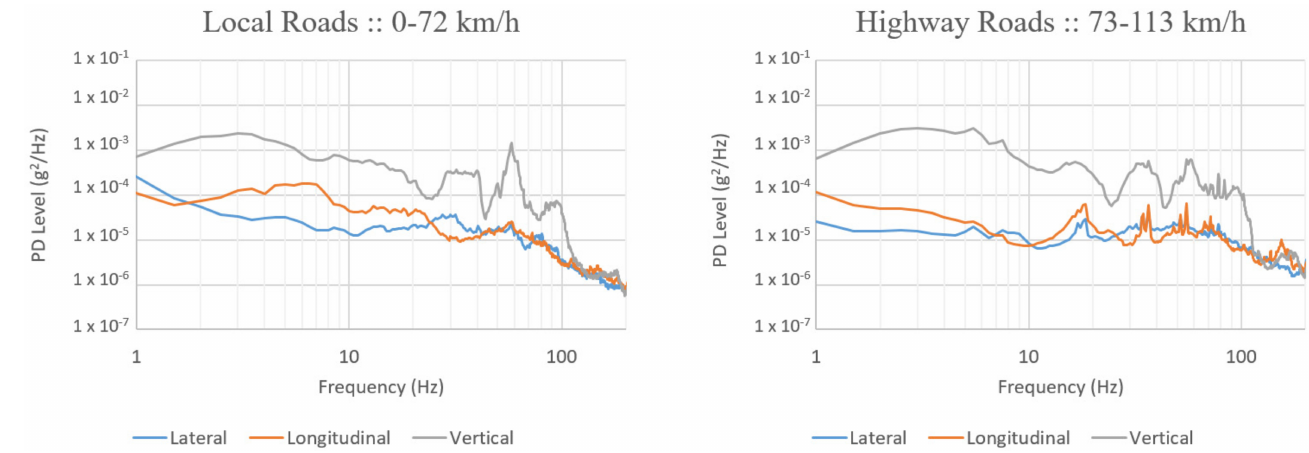
Figure 3. PSD plots for triaxial vibration of the GR86 sport